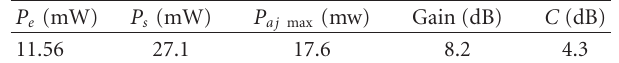
Table 1: K x and a x values of the internal LF noise sources for each frequency.